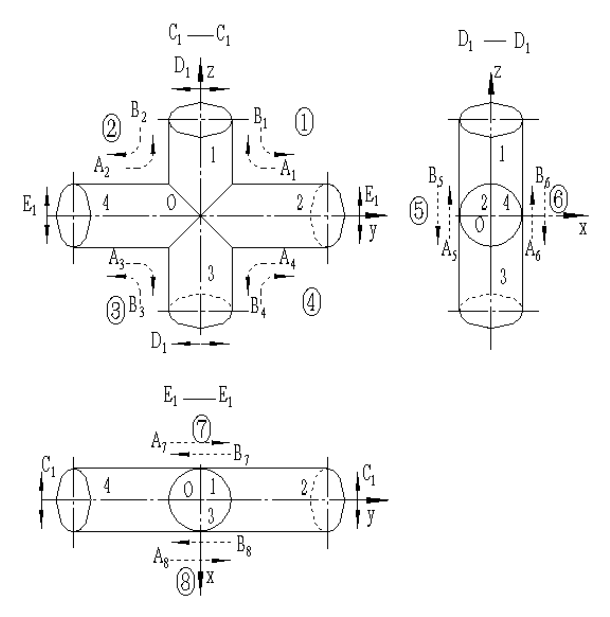
Fig. 11 Motion planning for the ‘+’